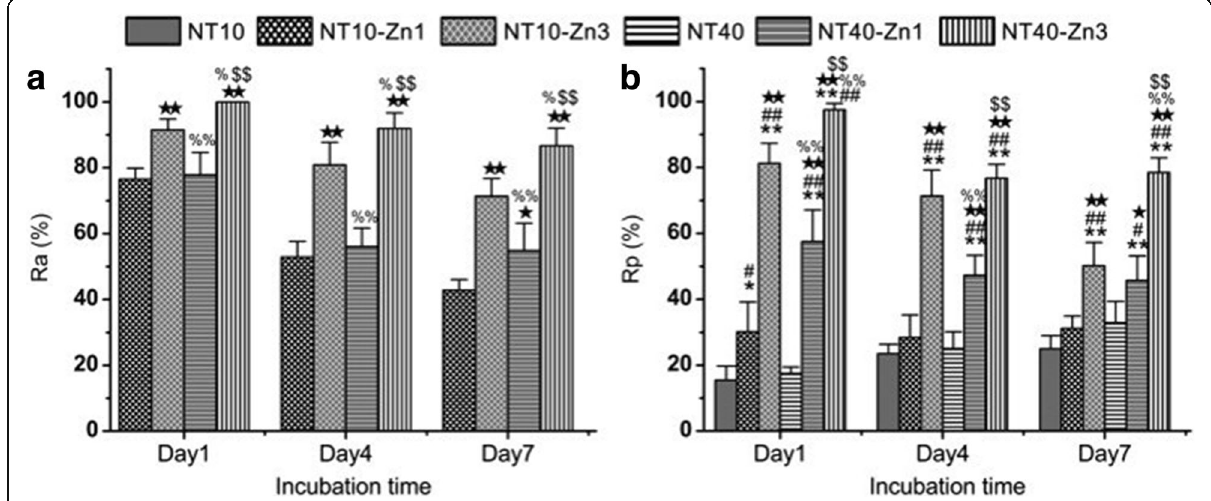
Fig. 12 a Antibacterial rates versus adherent bacteria on the specimen (Ra) and b antibacterial rates against planktonic bacteria in the medium (Rp) *, ** p < 0.05 and 0.01 vs NT10; # , ## p < 0.05 and 0.01 vs NT40; ★ , ★★ p < 0.05 and 0.01 vs NT10-Zn1; % , %% p < 0.05 and 0.01 vs NT10-Zn3; $ , $$ p < 0.05 and 0.01 vs NT40-Zn1. Reproduced from ref.